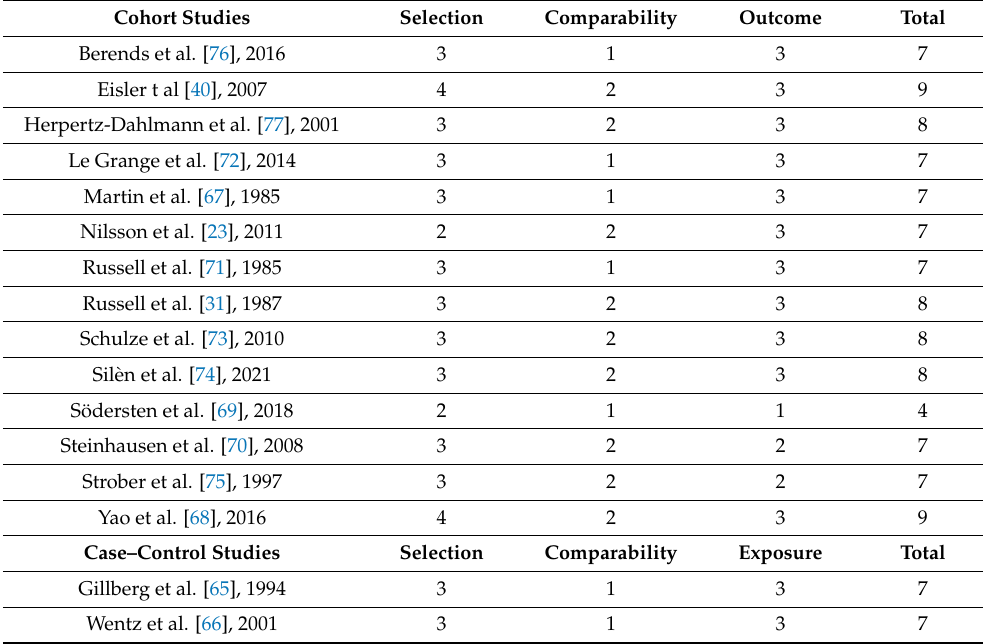
Table 3. Risk of bias assessment of included studies using the Newcastle–Ottawa